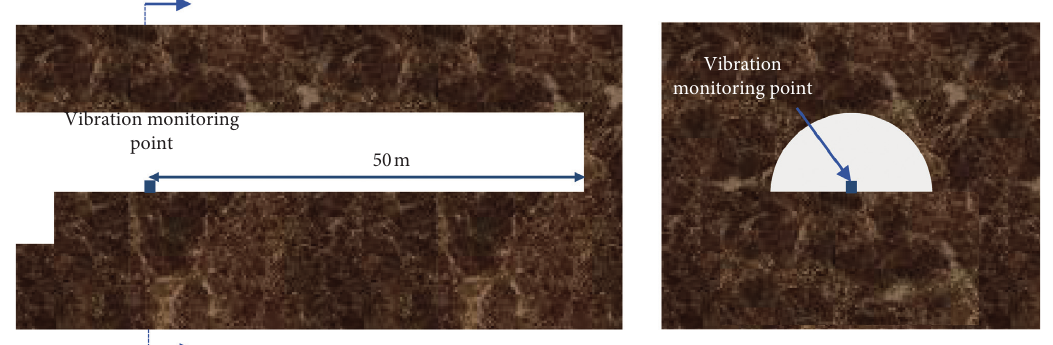
Figure 5: Layout of vibration monitoring points.